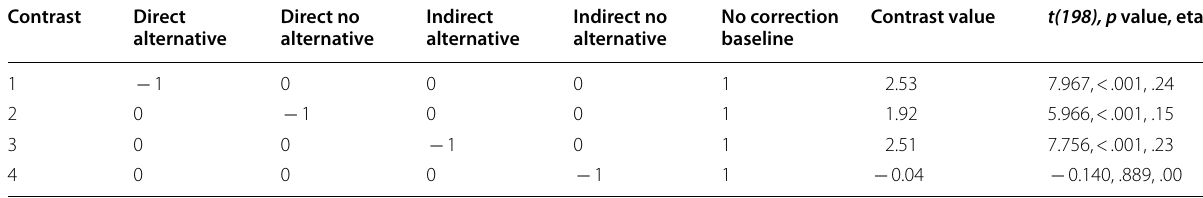
One-way ANOVA, F (4, 198)